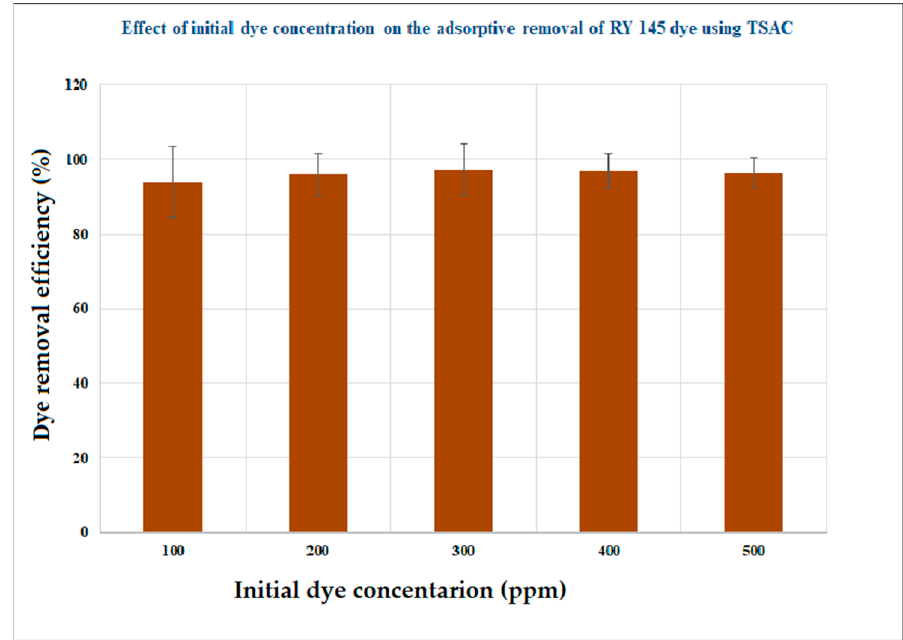
Figure 14. Effect of initial concentration of RY 145 dye on its adsorption onto the TSAC (Adsorbent dose = 0.3 g/L of solution; pH = 6; time = 120 min).